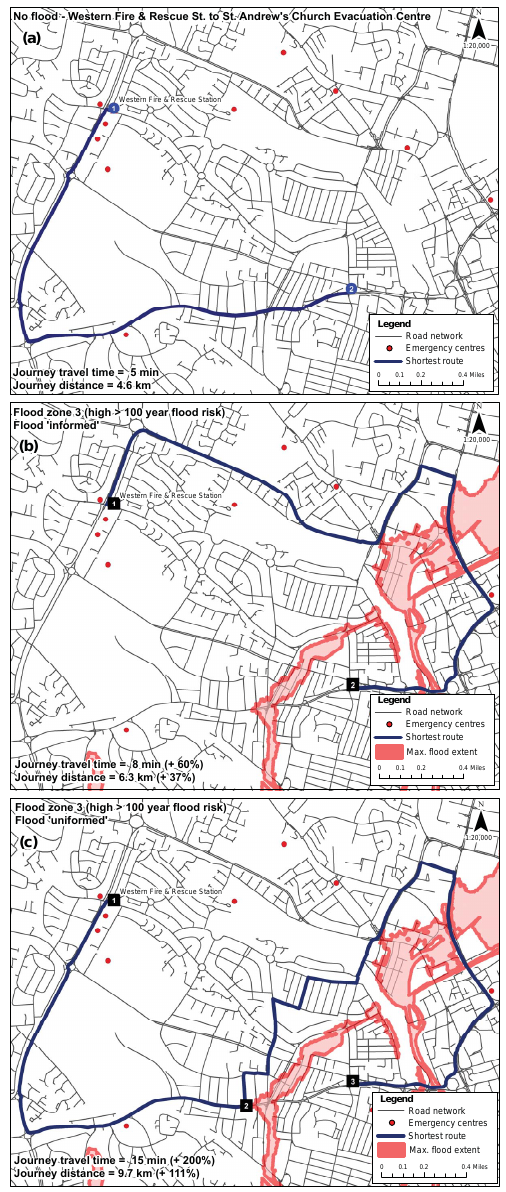
Figure 5. Quickest routing between the Western Fire and Res- cue Station and St. Andrew’s Methodist Church (evacuation cen- tre, 300-person capacity) under (a) normal conditions and high (>100 year) fluvial flood risk scenarios. (b) A prepared and “in- formed” scenario where first responders are aware of network re- strictions before responding, whereas (c) shows a “uniformed” sce- nario where impassable floodwaters are encountered by responders en